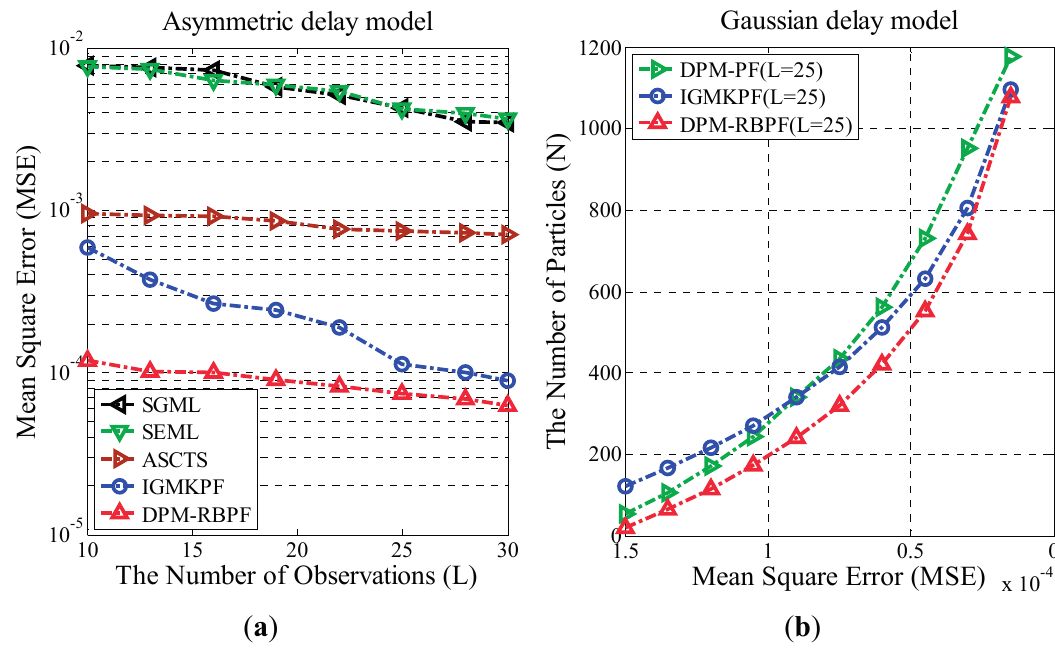
Figure 4. ( a ) MSE of clock offset estimators for mixing of a Gaussian and an exponential; ( b ) The relationship between the number of particles and